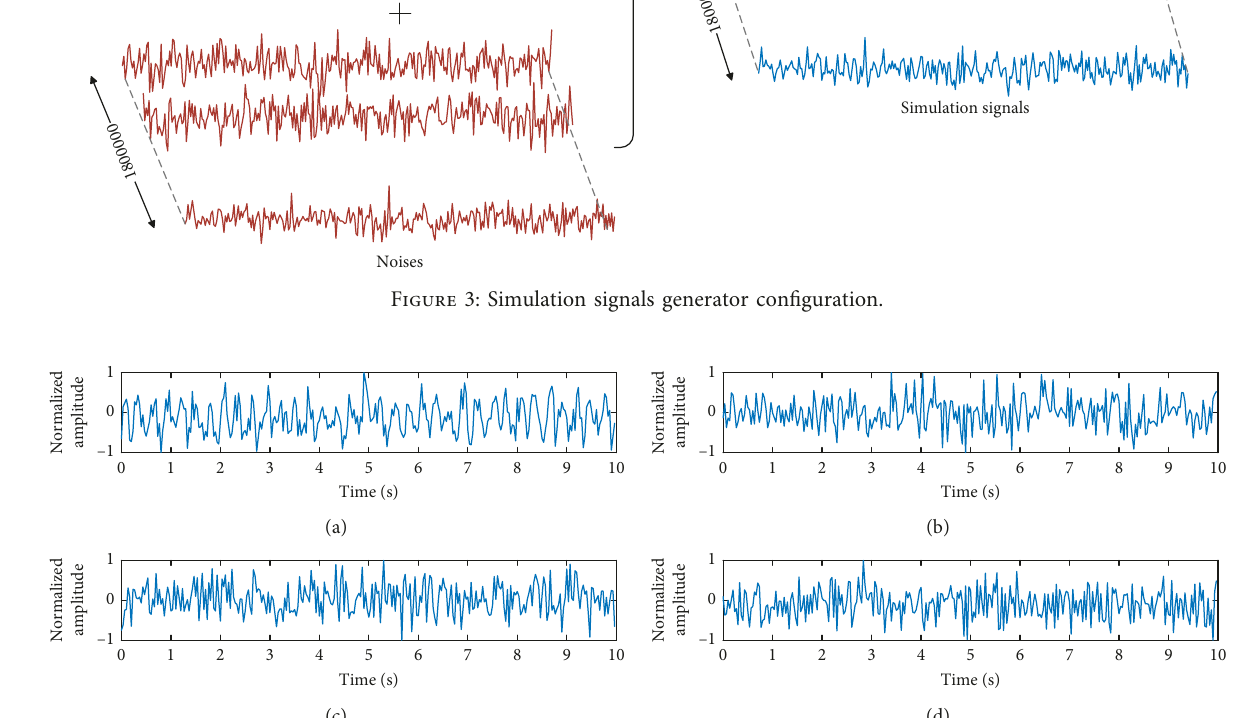
Figure 4: Examples of simulation signals with different vibration frequencies: (a) 3.6Hz; (b) 6.6Hz; (c) 9.6 Hz; (d) 12.6Hz.